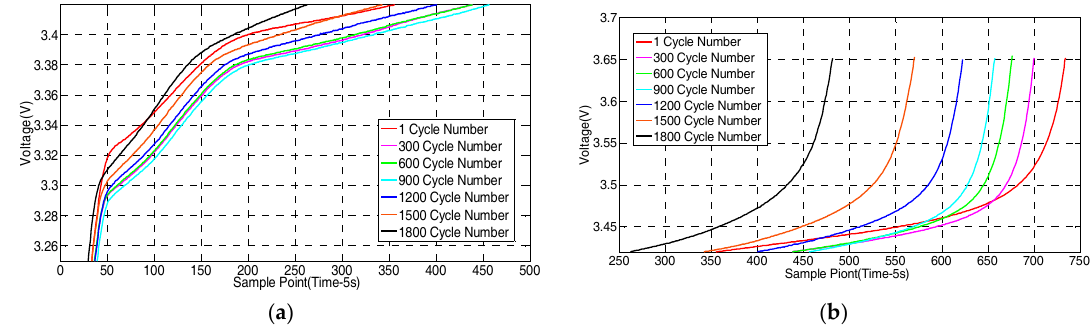
Figure 4. Voltage curves: ( a ) charge plateau region voltage; and ( b ) terminal voltage region.